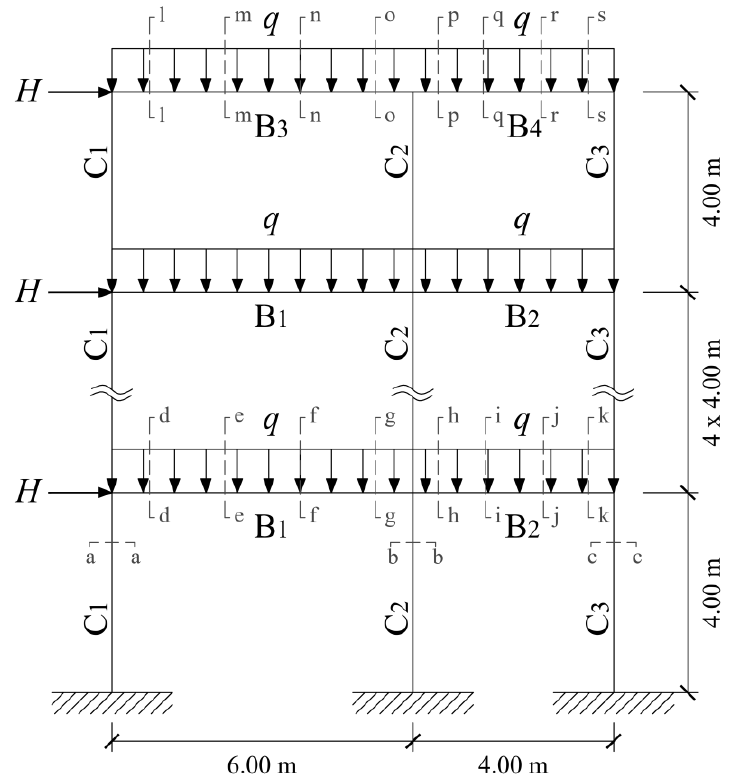
Figure 9. Plane frame - Example II.